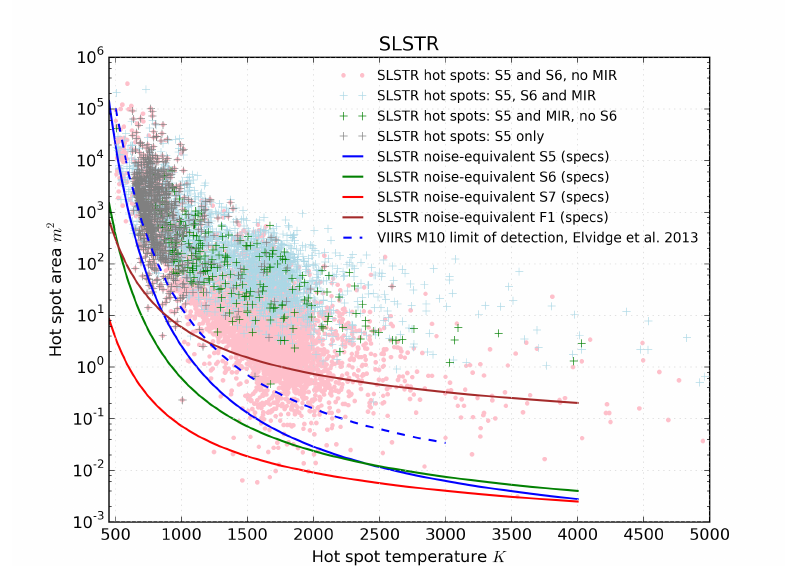
Figure 8. Relationship between the temperatures and areas of all retrieved hot spots. The solid lines represent the noise-equivalent radiance levels for SLSTR SWIR and MIR channels computed from the instruments specifications (see Figure 3). The dashed line represents the limit of detection for the VIIRS M10 channel derived by Elvidge et al.